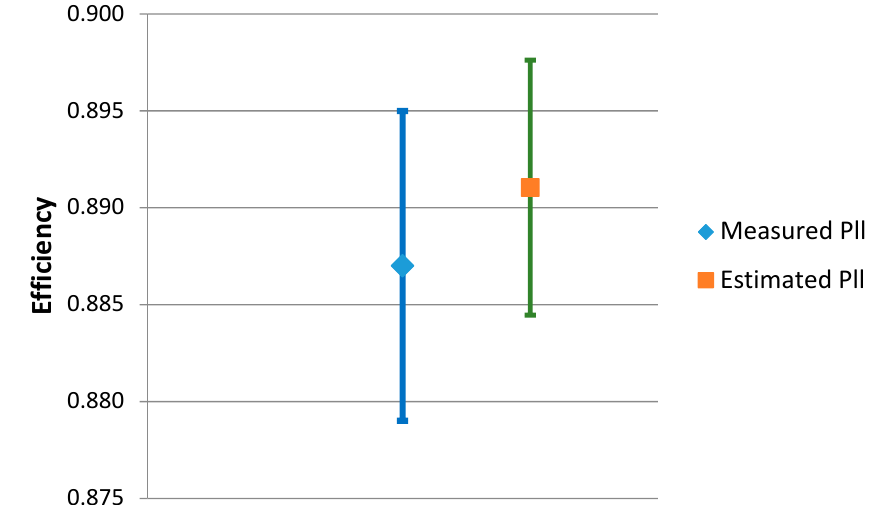
Figure 3. Comparison between the experimental efficiencies, with combined uncertainties.